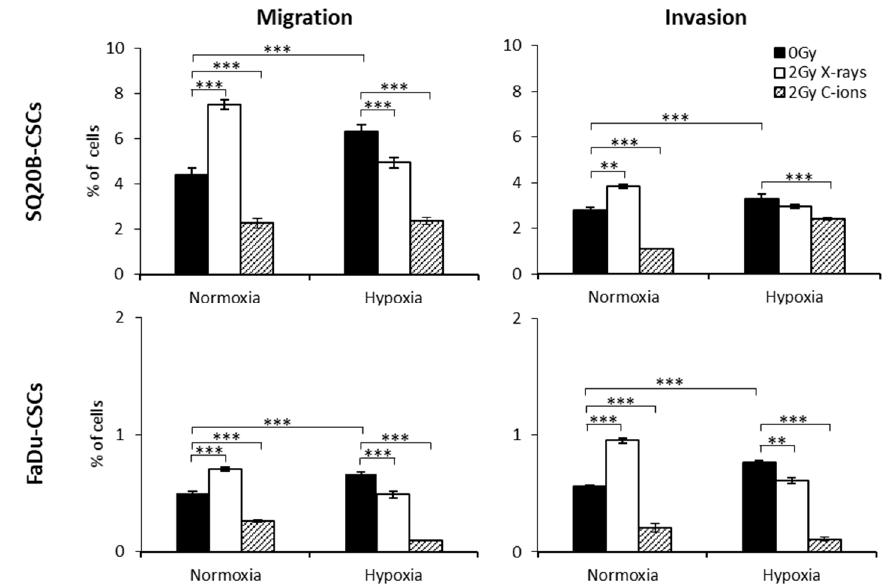
Figure 3. Effect of X-ray and C-ion irradiation on migration/invasion processes under normoxia and hypoxia. Three independent experiments using Boyden chambers were performed in triplicate (mean ± SD of the percentage of SQ20B-CSCs and FaDu-CSCs that migrated into the chambers) after 2 Gy X-ray or C-ion irradiation and compared with those using sham-irradiated cells (0 Gy) under normoxia or chronic hypoxia (* p < 0.05, ** p < 0.01, *** p < 0.005, Student’s t test).